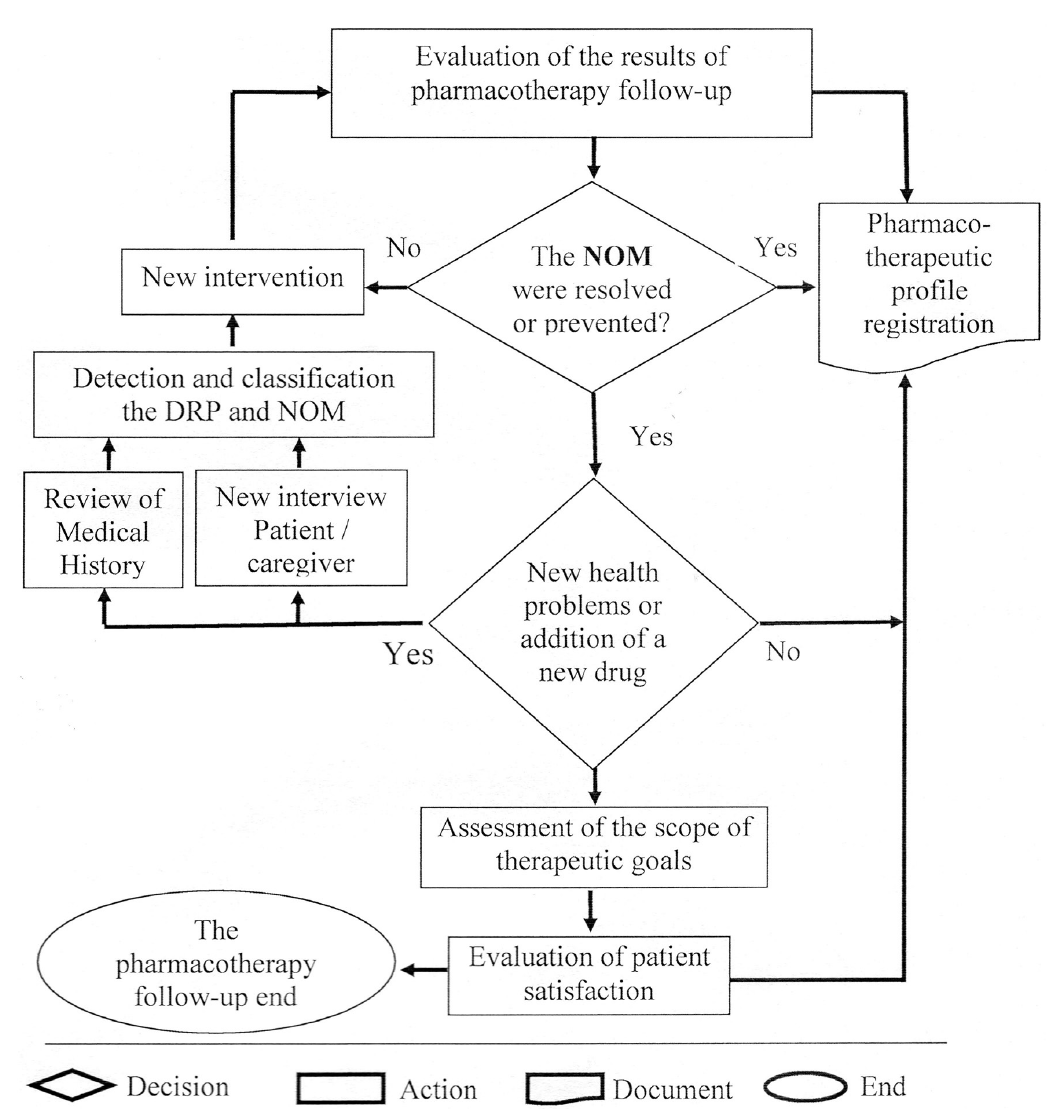
FIGURE 2 - Systematic evaluation of the pharmacist’s interventions in the pharmacotherapy follow-up. Legend: DRP: Drugs-Related Problem. NOM: Negative Outcomes associated with